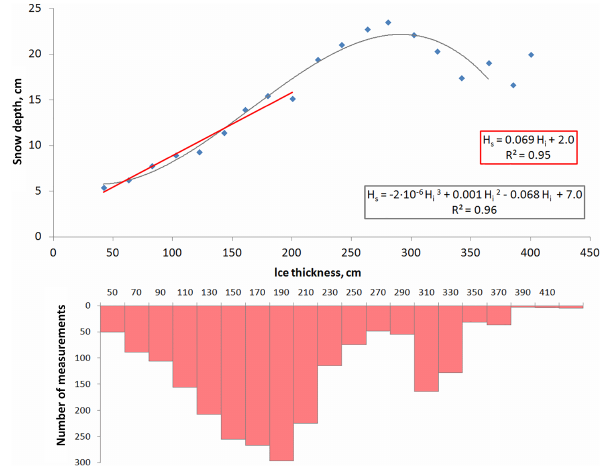
Figure 7. The relation between the thickness of the undeformed ice and the depth of accumulated snow in the end of winter.